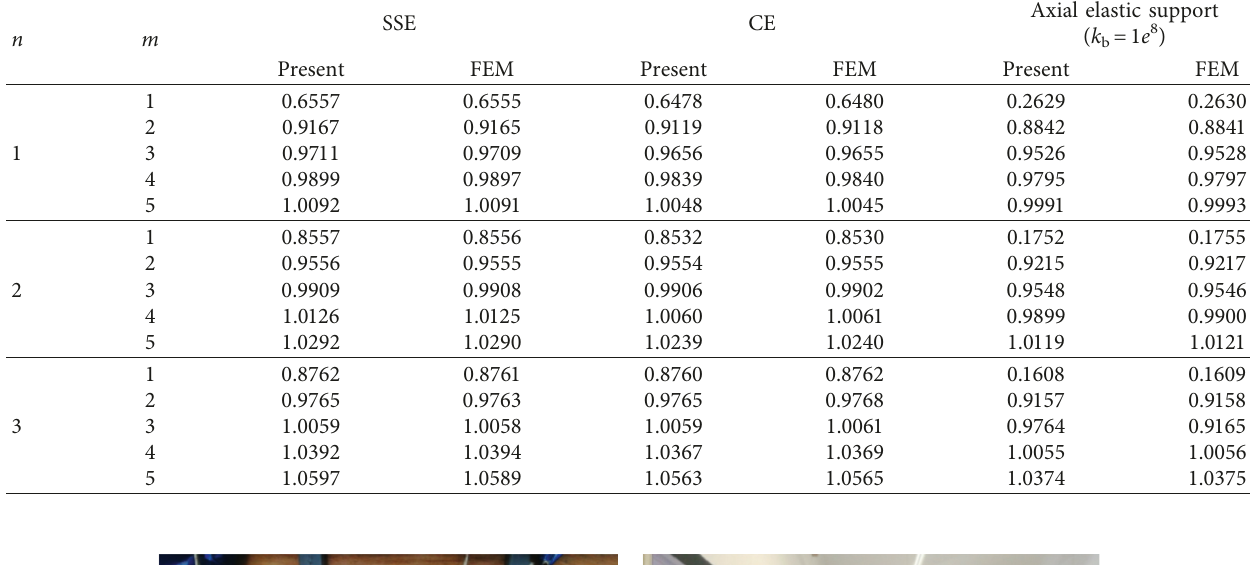
Table 4: Frequency parameters Ω of stepped hemispherical cap with different boundary conditions using the current method and FEM.